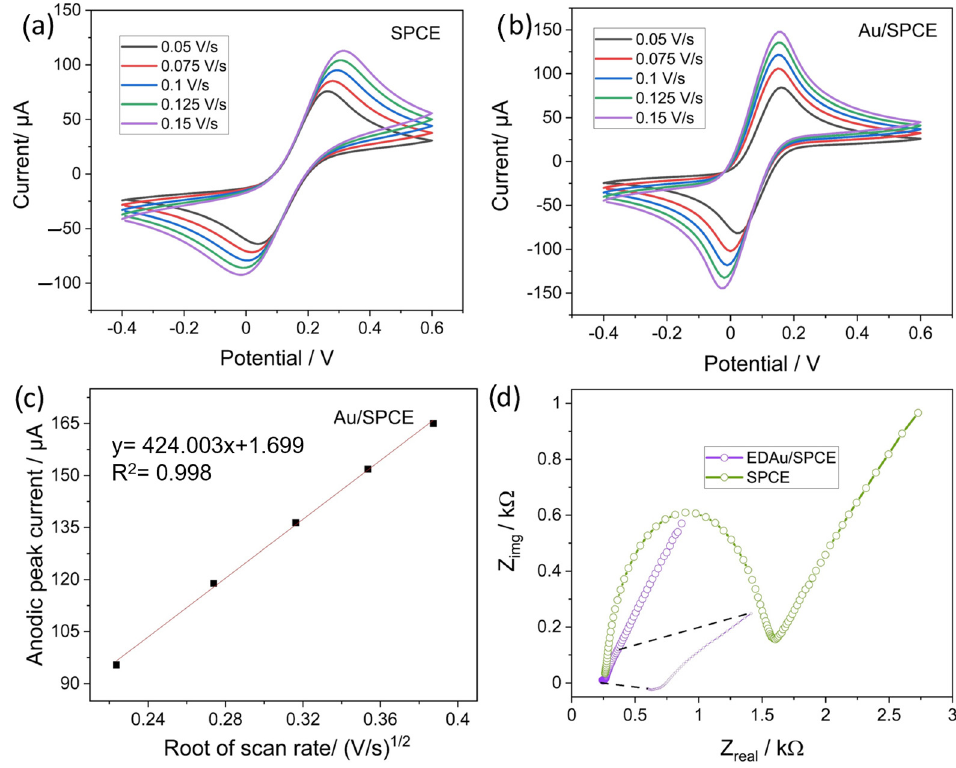
Figure 4. ( a , b ) show the CV curves at different scan rates in 5 mM K 3 Fe(CN) 6 ] 3 − /4 − solution for the SPCE and EdAu/SPCE electrodes, ( c ) depicts the linearity between the anodic peak current and the root of the scan rate for the EdAu/SPCE electrode, and ( d ) is the Nyquist plot of the SPCE and EdAu/SPCE electrodes.